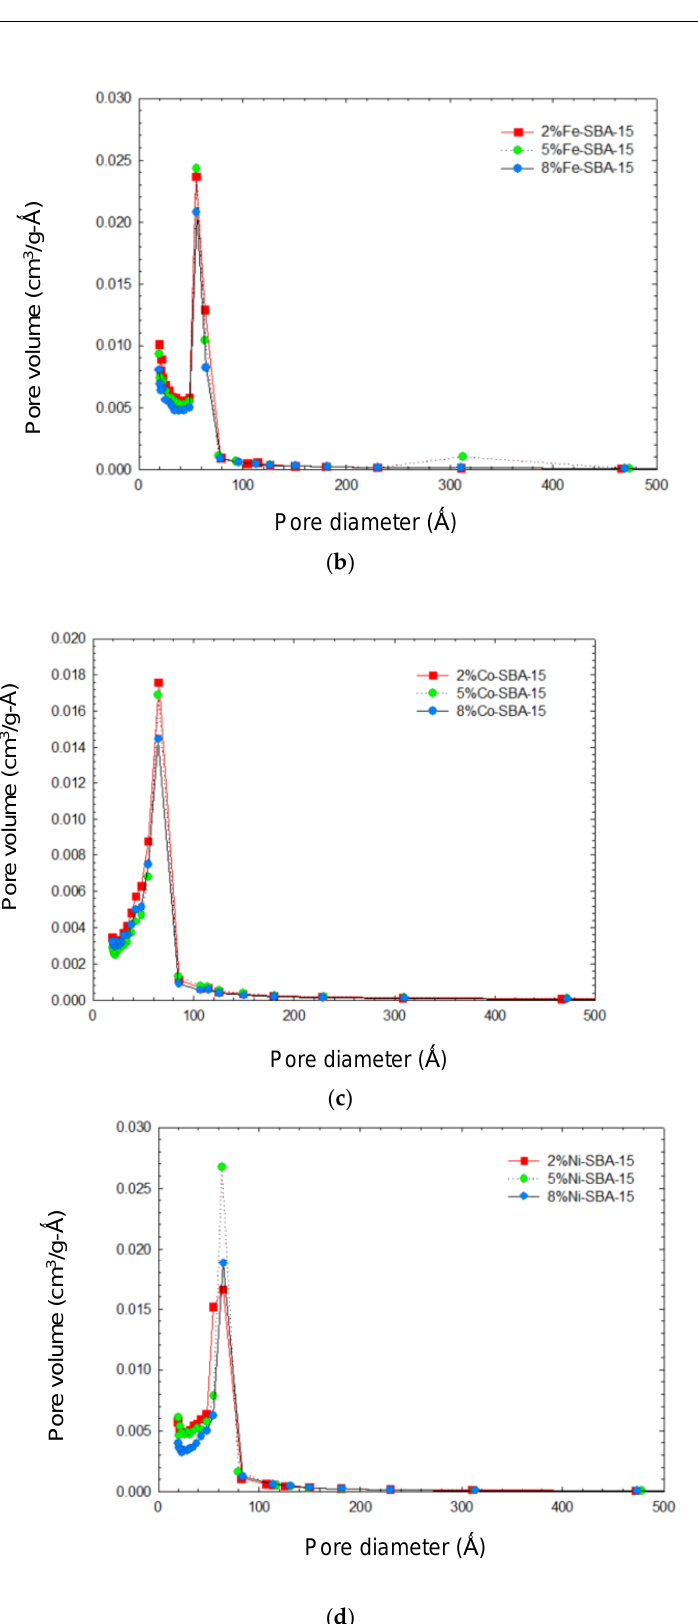
Figure 4. ( a ) Pore size distribution of SBA-15and 5 wt% (Fe, Co, Ni)-SBA-15. ( b ) Pore size distribution of 2–8 wt% of Fe-SBA-15. ( c ) Pore size distribution of 2–8 wt% of Co-SBA-15. ( d ) Pore size distribution of 2–8 wt% of